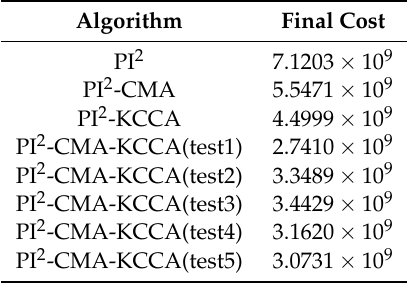
Table 3. The final cost of two via-point task with